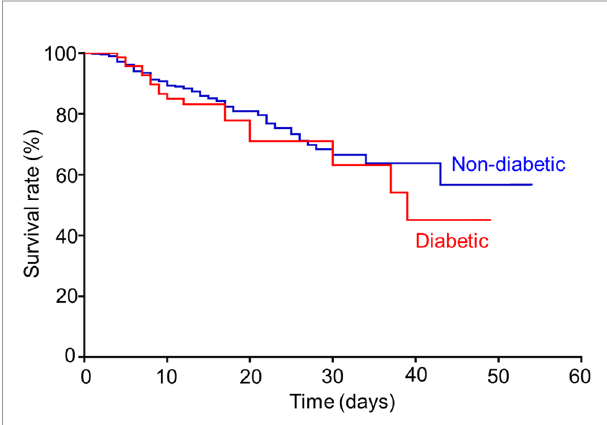
FIGURE 1 | Kaplan-Meier survival curve for COVID-19 patients with or without comorbid